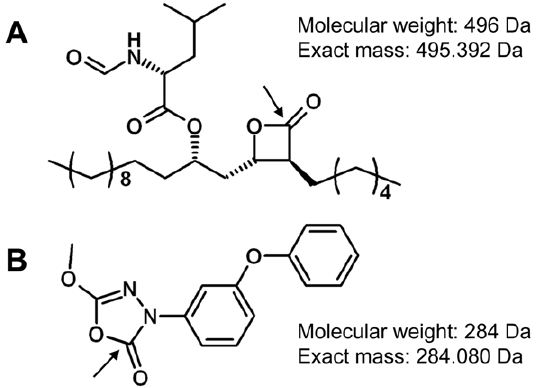
Figure 1. Chemical structure of inhibitors. Chemical structures of A , THL and B , M m PPOX. The proposed mechanism of action involves the opening of the cycle in each molecule. Nucleophilic sites attacked by catalytic serine are indicated by an arrow. Theoretical exact masses were calculated using the online calculator provided by SIS, Inc. (http://